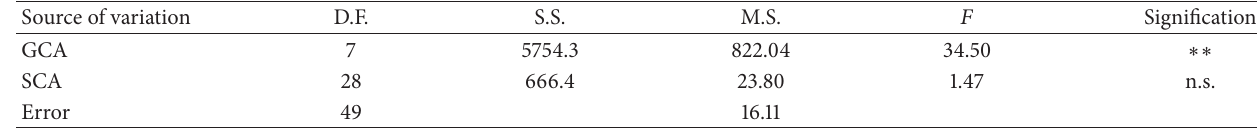
Table 5: Analysis of variance of combining ability of F1 at seedling stage.